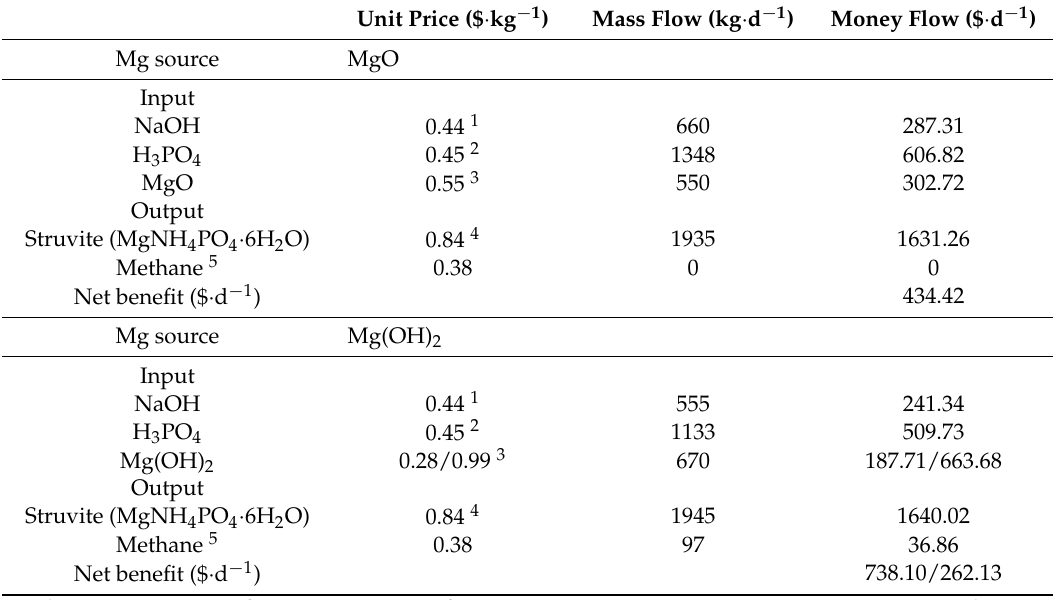
Table 8. Economic analysis of the struvite precipitation (SP)